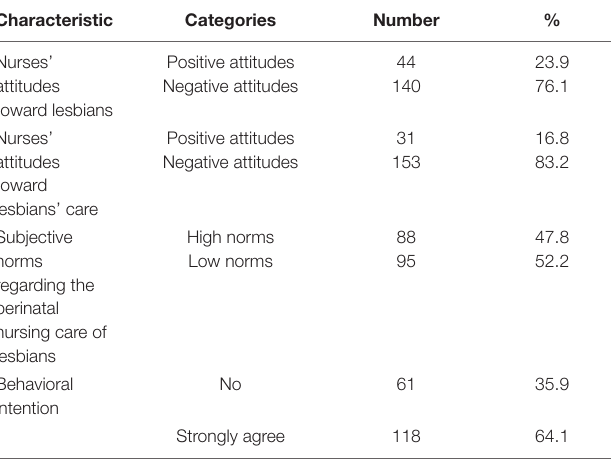
TABLE 1 | Personal and professional characteristics of the participants: categorical variables ( N = 184).